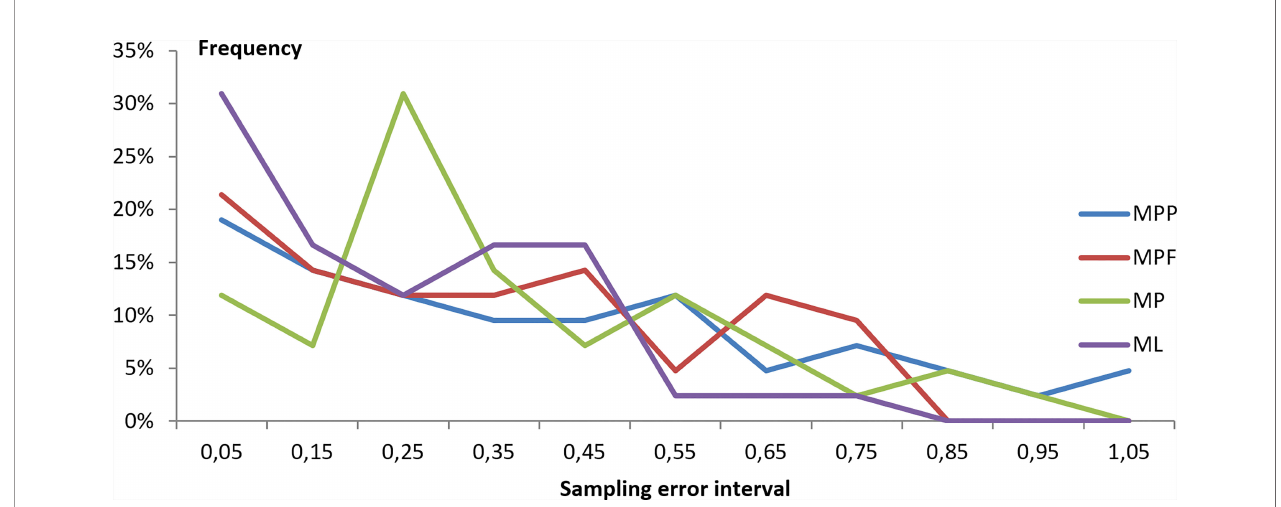
FIGURE 3 | Frequency distribution of sampling error in the sampling boxes of a few kilometers by a few hours from TalTech data. The frequency is calculated for a sampling error bin of 0.1 interval.